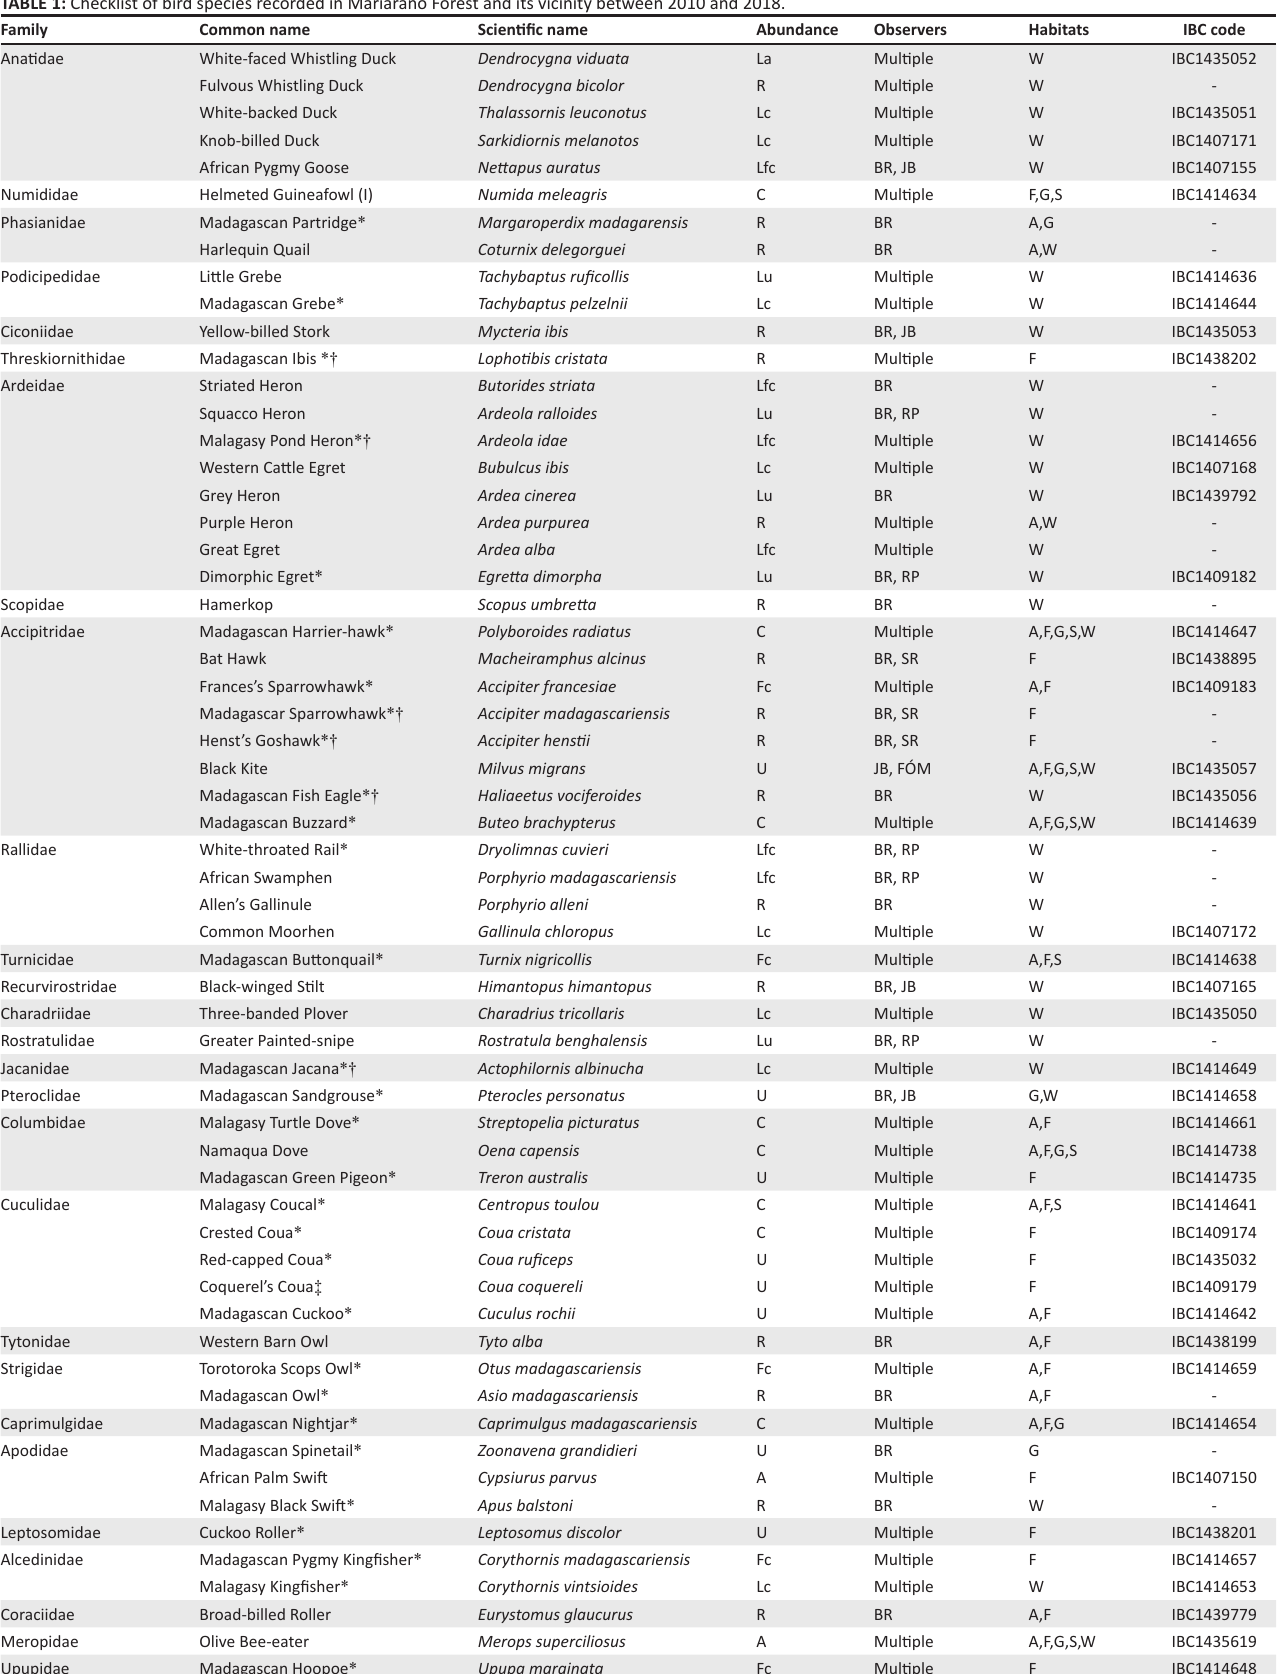
TABLE 1: Checklist of bird species recorded in Mariarano Forest and its vicinity between 2010 and